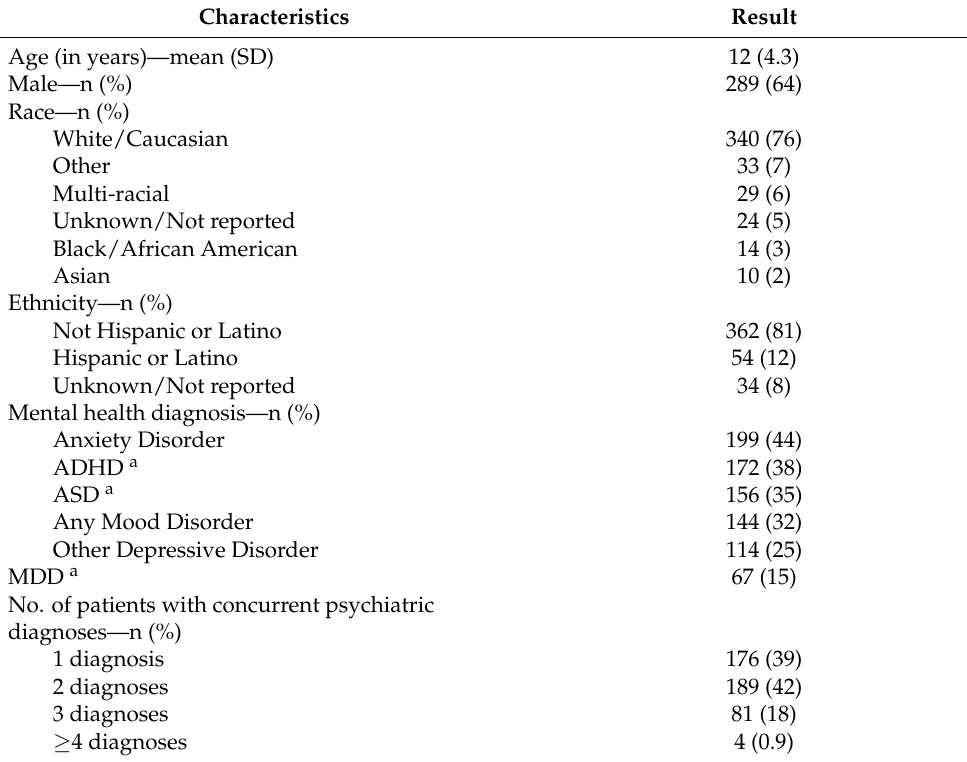
Table 1. Basic demographic and medical profiles of study cohort (N =